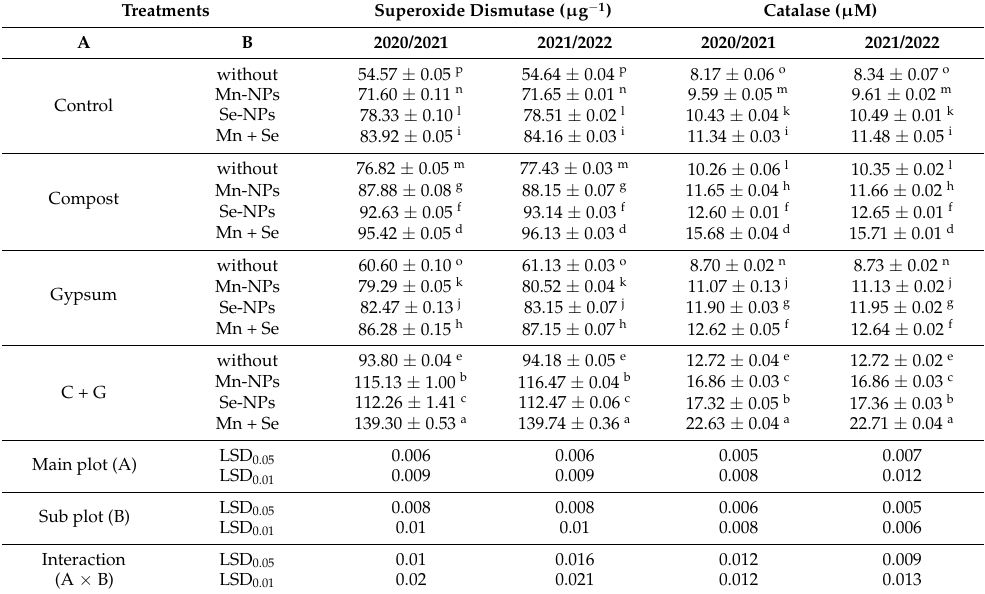
Table 5. Combined effects of soil amendments and foliar application of some nanoparticles on superoxide dismutase (SOD) and catalase (CAT) of faba beans during the 2020/2021 and 2021/2022 growing